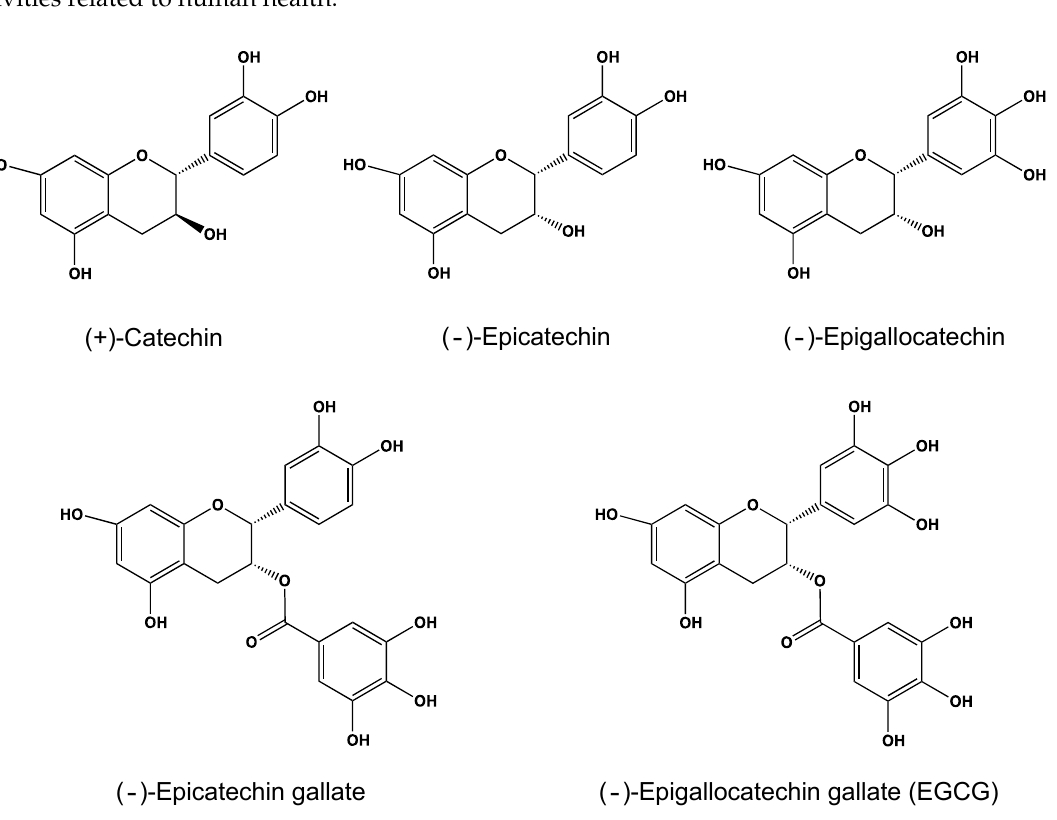
Figure 1. (+)-Catechin and major green tea catechins.